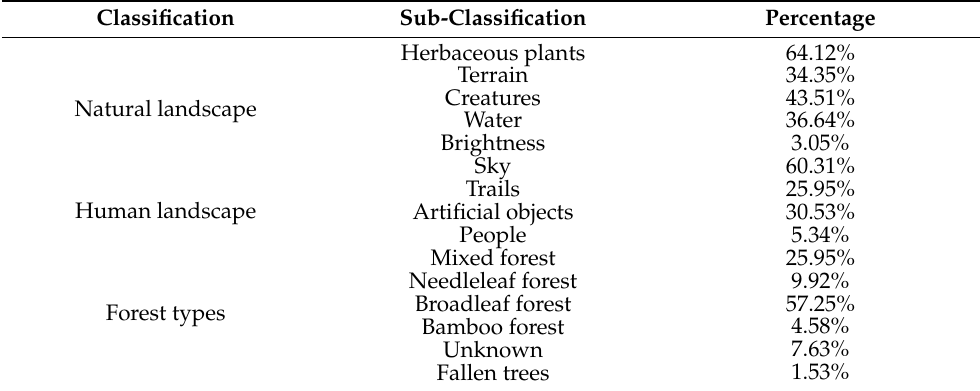
Table 1. Statistical data for landscape element and forest types in sketches.